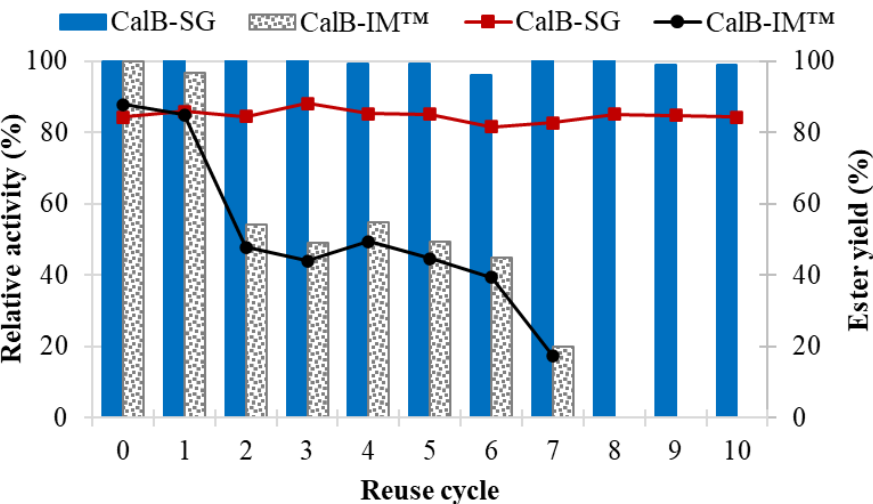
Figure 6. Operational stability of lipase from Candida antarctica B in successive batch reaction cycles of caproic acid esterification with n -amyl alcohol at 36 ◦ C, in a solventless medium. The column diagram depicts the relative activities, while ester yields are shown in red (CalB-SG lipase, immobilized by sol-gel entrapment) and black (CalB-IM™ lipase, immobilized by adsorption onto ion exchange resin) line segments, respectively.